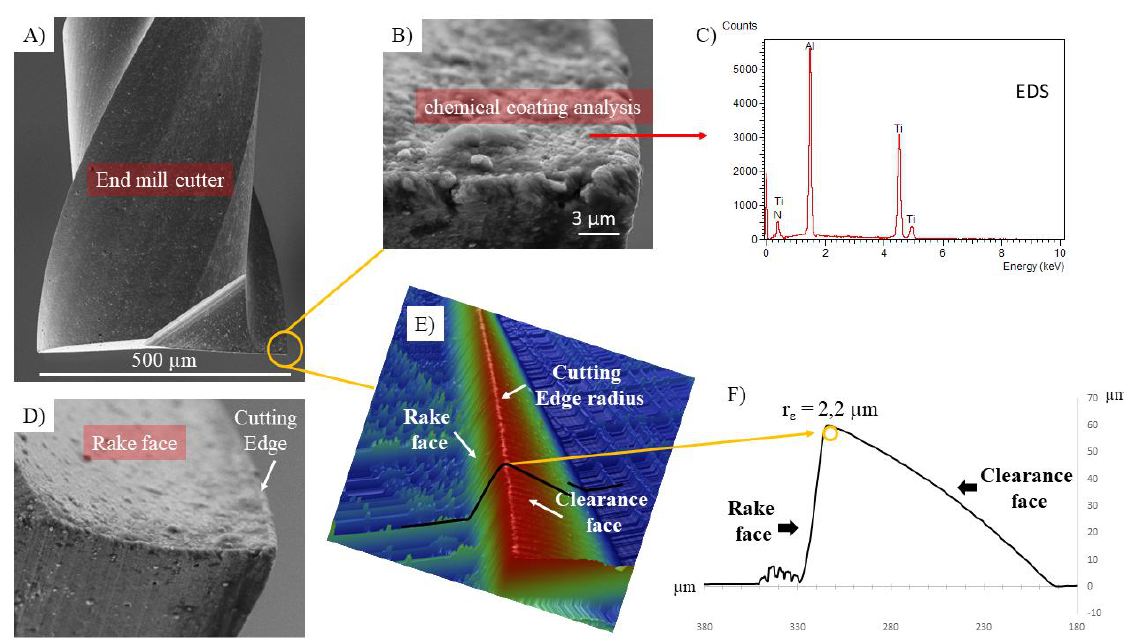
Figure 1: Characterization of the micro tool. A) Tip of the micro end mill. B) Higher magnification of the cutting edge for EDS analysis. C) Result of the EDS chemical analysis. D) Edge view by SEM. E) Confocal view to measure the edge radius. F) Measurement of the edge radius.